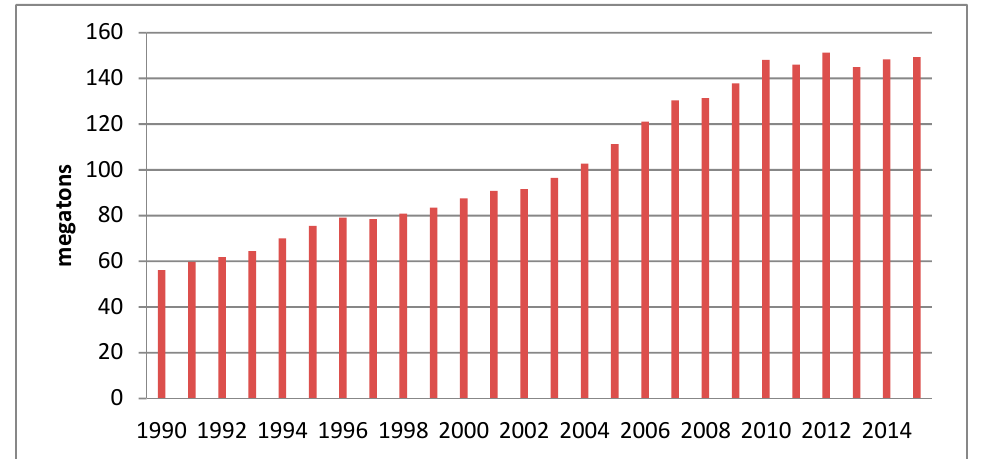
Figure 2. CO 2 emissions in Beijing from 1990 to 2015.